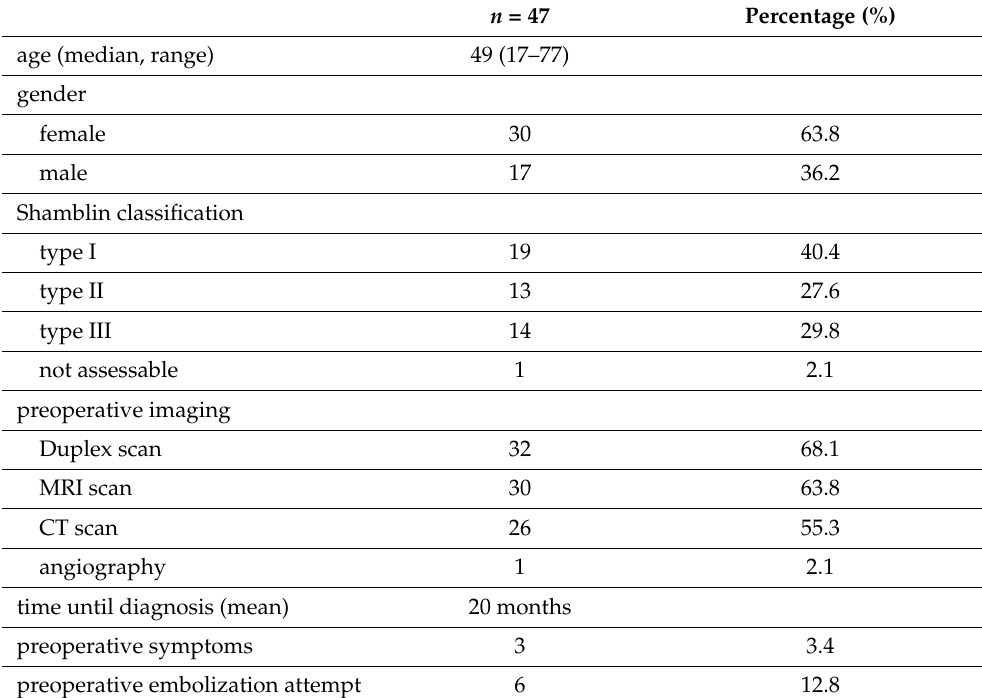
Table 1. Tumor characteristics and demographics. MRI: magnetic resonance imaging; CT: computed